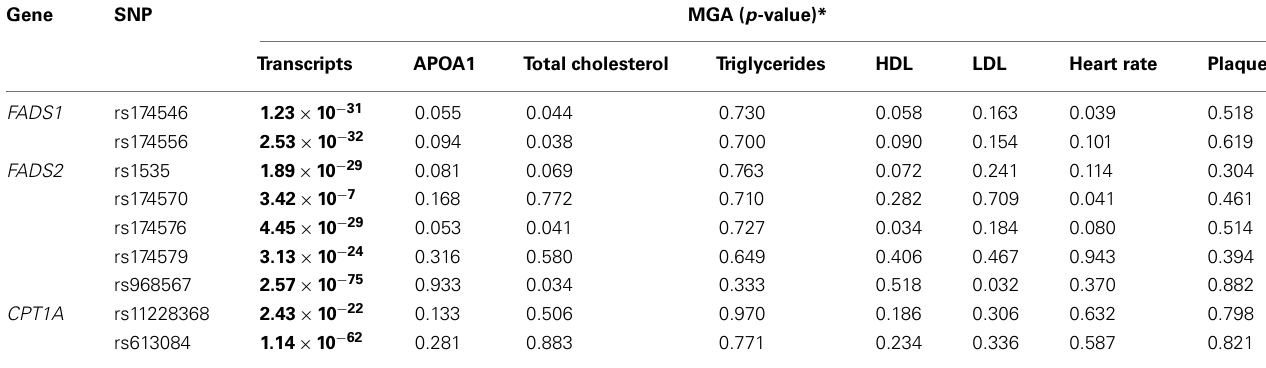
Table 6 | Measured genotype association results for SNPs with CVD-related phenotypes and cis -regulated transcripts in MexicanAmericans. Gene